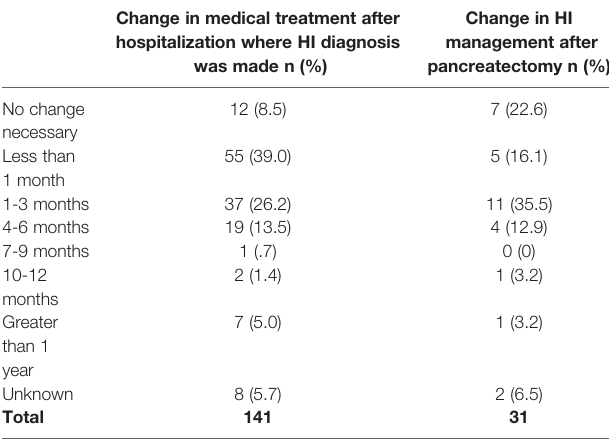
TABLE 5 | Age participant ’ s symptoms were fi rst noticed.